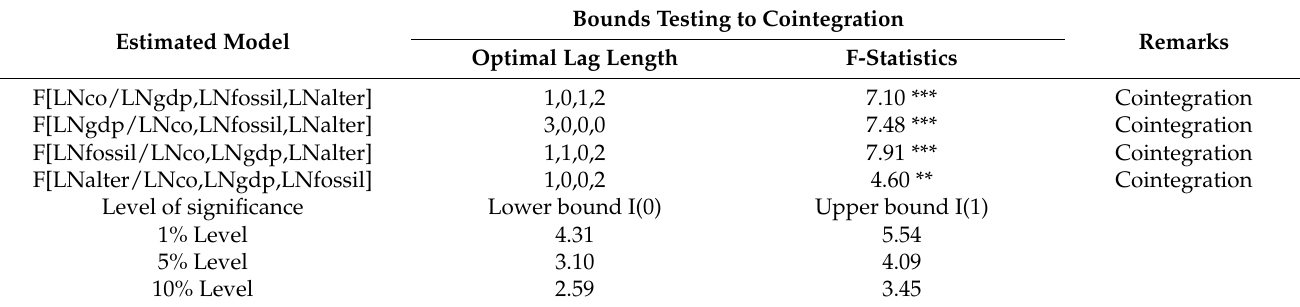
Table 3. Results of ARDL bounds